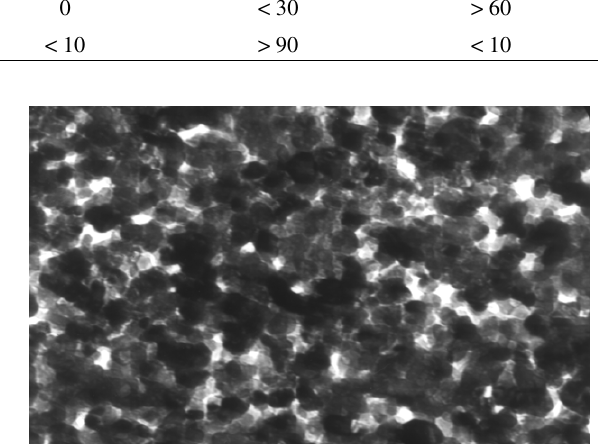
SrTiO 3 crystallized thin films